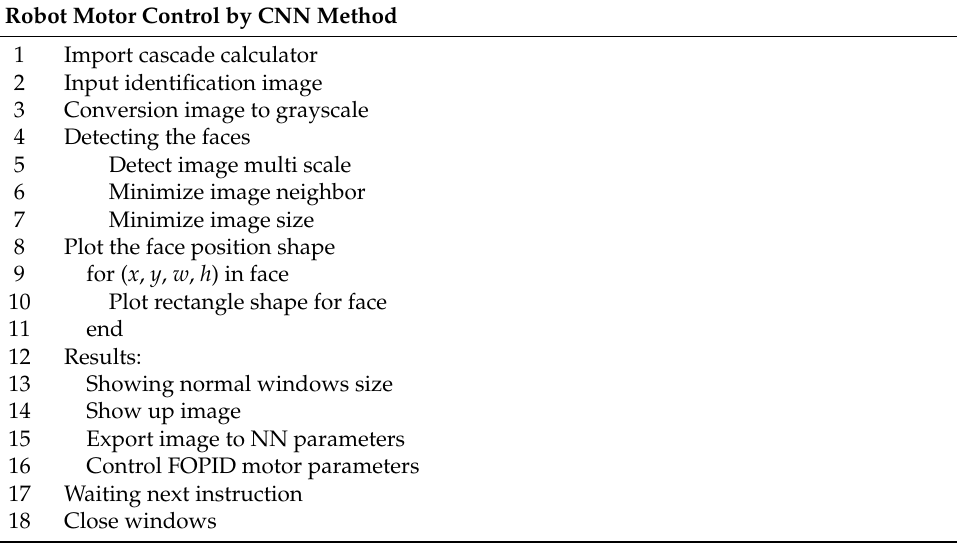
Table 3. CNN recognition control robot AI motor.